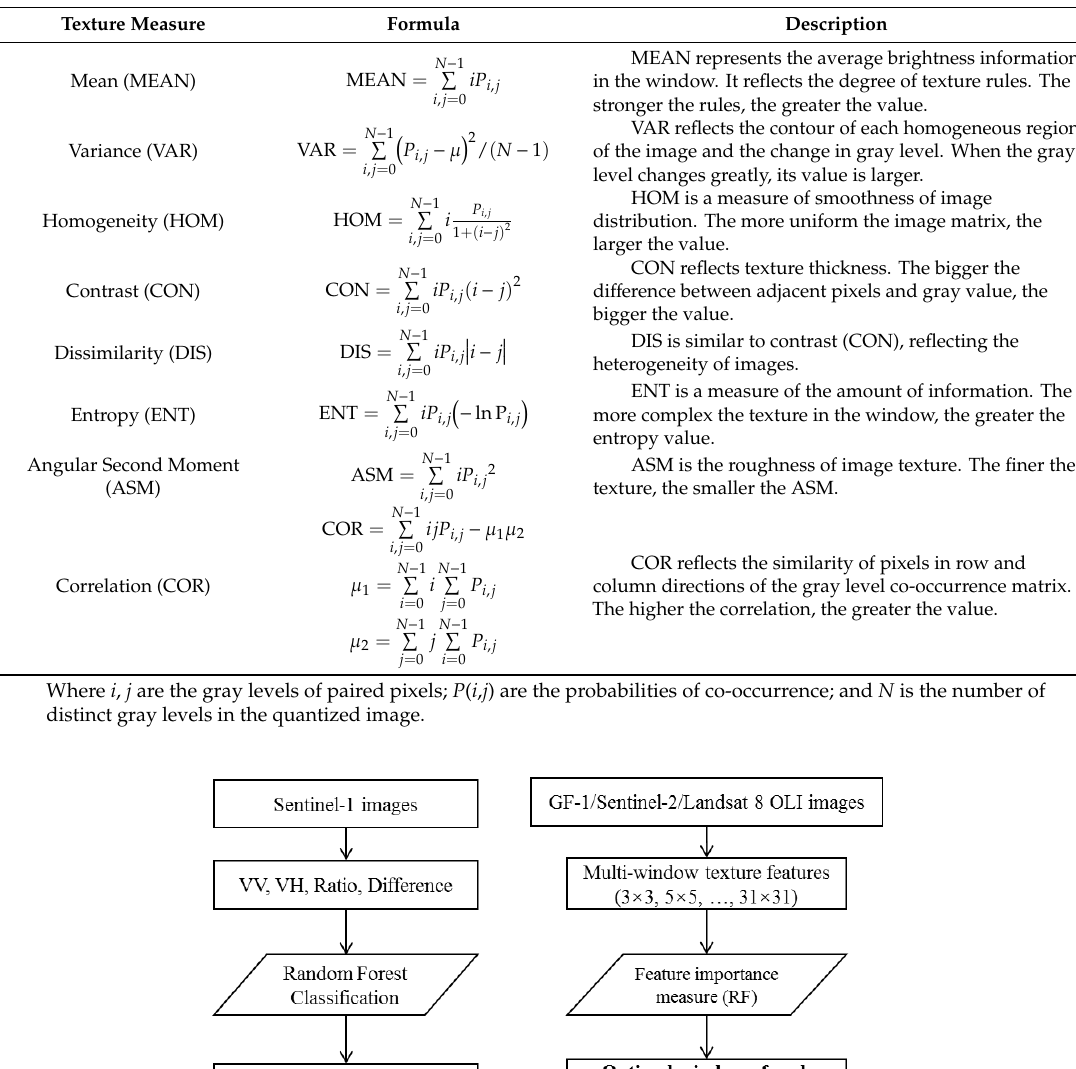
Table 2. Image texture measure formulas.